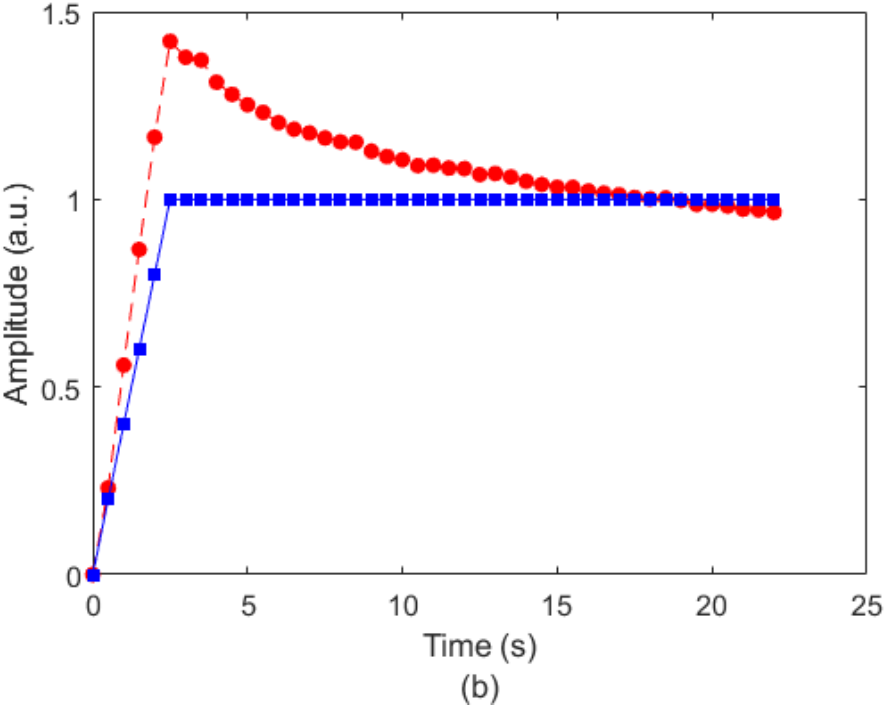
Figure 6. ( a ) Force and displacement estimation with FBG wavelength shift and reflected optical power; ( b ) force as a function of time for a step displacement input.